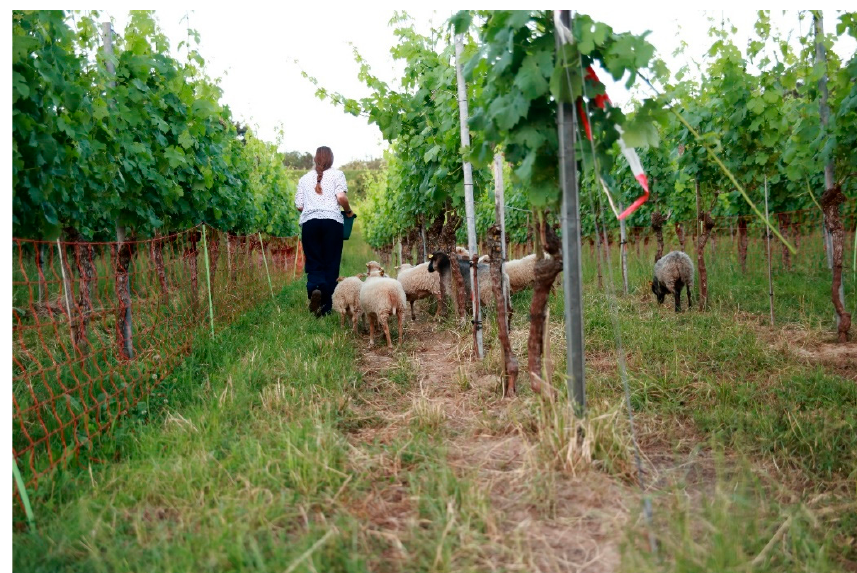
Figure 2. Ouessant sheep grazing in a vineyard with Guyot pruning (see above). In this viticultural system the browsing-sensitive (critical) phases of the growing season comprise the time from budding till the time berries reach groat-size and then from the veraison (start of the ripening of the grapes) through to harvest time. To avoid damage, sheep should not be allowed to graze vineyards during these critical phases. For grazing outside of the two described critical phases, some breeds seem much more suitable than others [10].